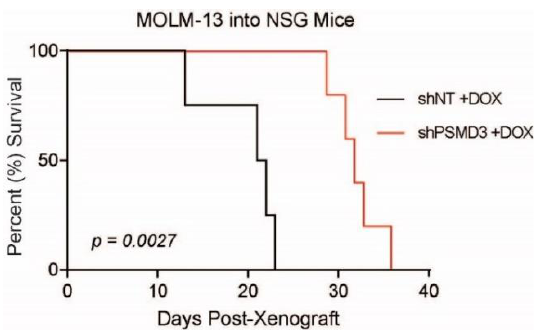
Figure 3. shPSMD3 enhanced survival of MOLM-13 cells engrafted into NOD-scid IL2Rgamma null (NSG) recipient mice. Kaplan – Meier curve shows overall survival (OS) of sublethally irradiated NSG recipient mice upon intravenous injection of MOLM-13 cells (3 × 10 6 ) expressing either shPSMD3 ( n = 5) or the non-targeting shNT control vector ( n = 4) and treated with doxycycline (DOX, 625 mg/kg).